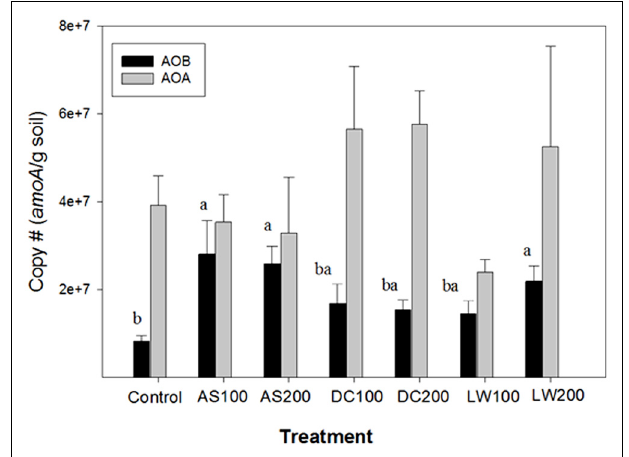
FIGURE 1 |AOB andAOA copy # of amoA gene per gram of soil treated with ammonium sulfate (AS), dairy waste compost (DC), and liquid dairy waste (LW) at two rates of application, 100 and 200 kg N ha -1 . Bars with same letter superscript are not significantly different at p ≥ 0.05. No significant difference was found between the treatments for AOA copy